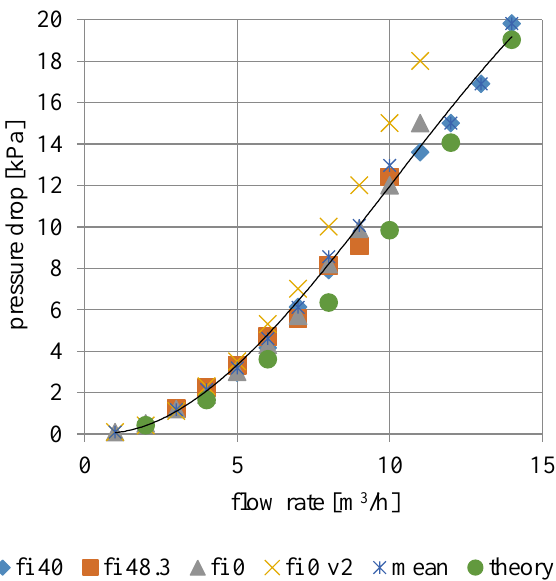
Fig 5: Pressure drop measurements of the irradiation channel outlet.